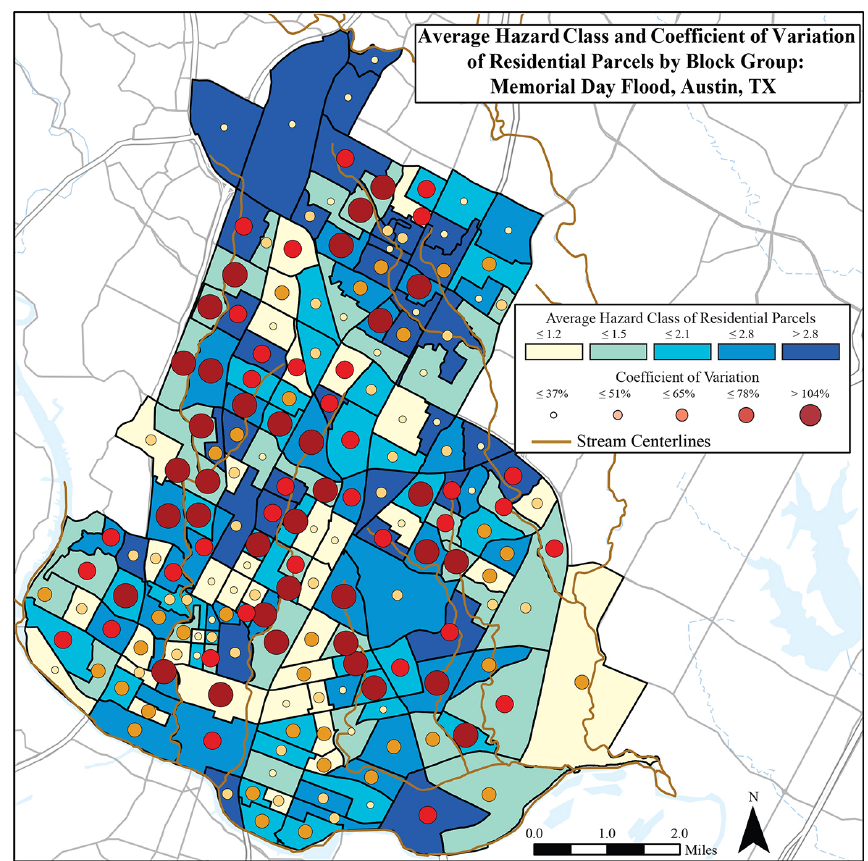
Figure 6. Average flood hazard class of residential parcels and their coefficient of variation by census block group during the 2015 Memorial Day flood in Austin, Texas. Darker block groups signify a higher average hazard class, and larger circles signify a higher coefficient of